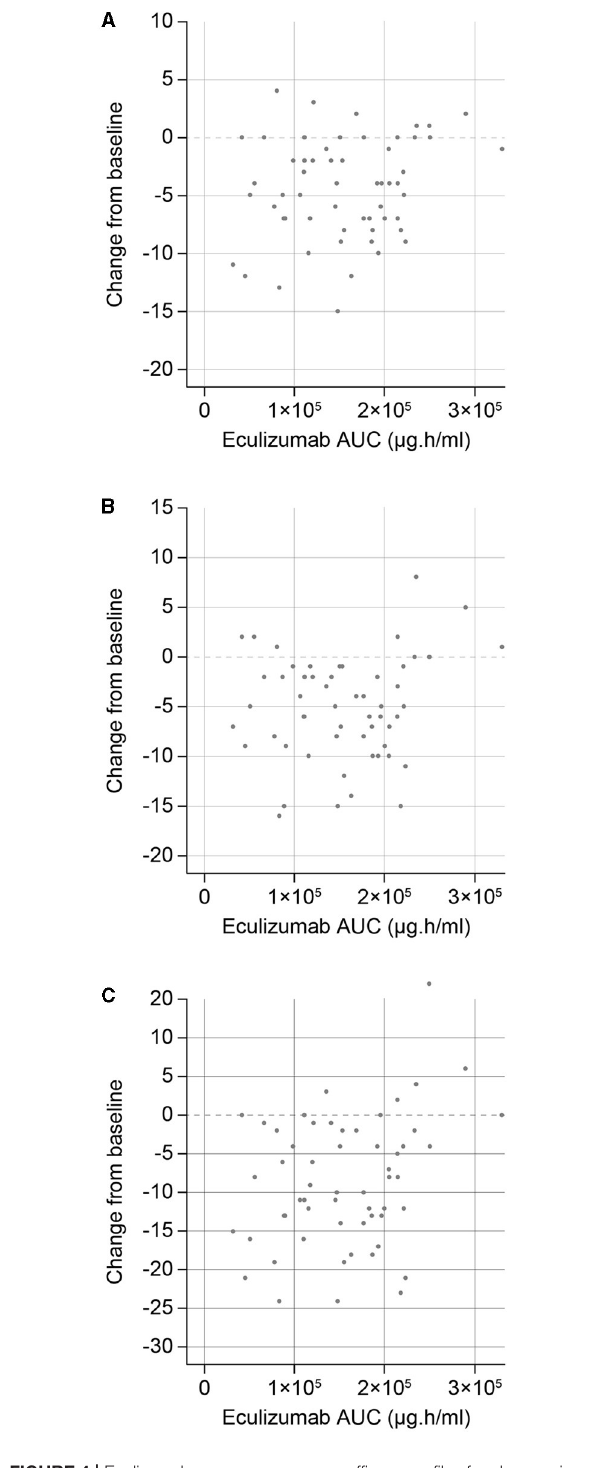
FIGURE 4 | Eculizumab exposure–response efficacy profiles for changes in (A) MG-ADL, (B) QMG, and (C) MGC total scores from baseline to Week 26. AUC, steady-state area under the concentration–time curve within the 2-week dosing interval; MG-ADL, Myasthenia Gravis-Activities of Daily Living; MGC, Myasthenia Gravis Composite; QMG, Quantitative Myasthenia Gravis